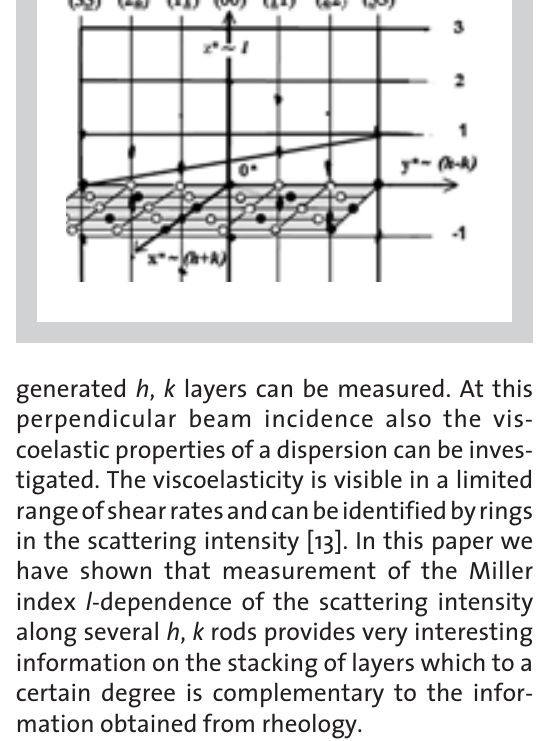
Figure 12: Results of the radial (dark plane) and tangential (in the background) synchro- tron x-ray scattering from a Couette cell, obtained for an about 30 vol% concentrated fcc single crystal (F ~ 100